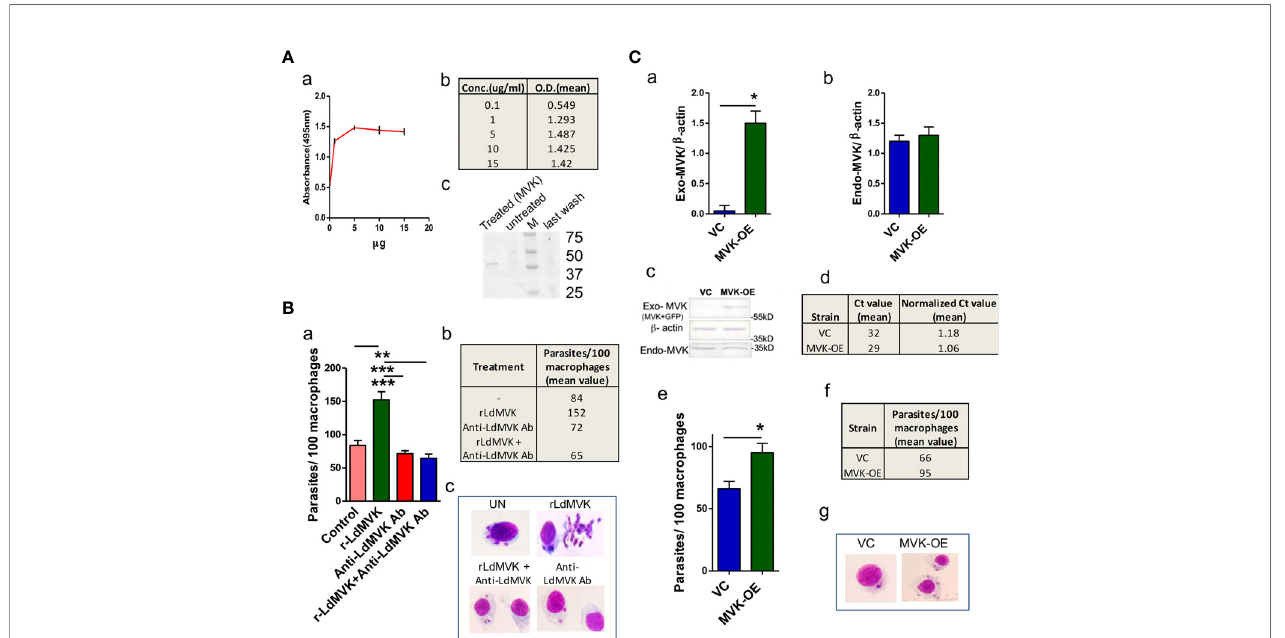
FIGURE 5 | LdMVK facilitates parasite invasion. (A) rMVK binds to the surface of macrophages. (a) Graph depicts the binding of rLdMVK on macrophages in a dose-dependent manner. Fixed macrophage cells were incubated with increasing protein concentration. The result shows mean of three independent experiments performed in triplicates. (b) Table representing the mean O.D. of experiments performed in triplicates of aforesaid described adhesion assay. (c) Blot representing binding of r-LdMVK to macrophage cell surface. PBMC-derived macrophage was incubated with r-LdMVK for 1 h, washed four times with PBS-CM, and lysed using RIPA buffer containing phosphatase inhibitors. Lysate was separated on SDS-PAGE gel and incubated in anti-MVK antibody. The image is representative of three independent experiments. Treated, macrophages incubated with r-LdMVK; untreated, macrophages without any protein incubation; M, protein marker; last wash, last wash of three washes performed post MVK incubation. (B) Infection of macrophages on rLdMVK treatment. (a) PBMC-derived macrophages were treated with Ld promastigotes, 1 µg/ml r-LdMVK+Ld promastigotes, anti-MVK antibody + Ld promastigotes and r-LdMVK + anti-MVK antibody + Ld promastigotes for 4 (h) Parasite to cell ratio was 10:1. Error bars shows SE from three independent studies. (b) Table depicting the mean value of parasites internalized per 100 macrophages on different incubations. (c) Representative image of Giemsa stained infected macrophages on various treatments. (C) Infection of macrophages by MVK-overexpressed and vector control parasites. (a) Bar graph representing normalized band intensity of exogenous MVK (exogenous-MVK/ b -actin) in VC and MVK-OE parasites. Error bars shows SE from three independent studies. (b) Bar graph representing no signi fi cant change in the level of normalized band intensity of endogenous MVK (endogenous-MVK/ b -actin) in VC and MVK-OE parasites. Error bars shows SE from three independent studies. (c) Western blot con fi rmation of generation of MVK-Overexpression strain. Whole cell lysate of MVK-Overexpression and vector control strains of Ag83 parasites were prepared, separated on SDS- PAGE gel, and probed with anti-MVK antibody. The image is representative of three independent experiments. VC, only pLGFPN transfected parasites; MVK-OE, GFP-tagged MVK-overexpressed parasites. (d) Real time PCR con fi rmation of generation of MVK-Overexpression strain. RNA from MVK-Overexpression and vector control strains of Ag83 parasites were prepared; after cDNA preparation real time PCR was carried out. Table is showing the mean normalized Ct value from these experiments. (e) Bar graph representing the number of internalized parasites per 100 macrophages. PBMC-derived macrophages were treated with mutant stains of parasites with 1:10 macrophage to parasite ratio for 4 (h) Macrophages were washed, stained, and internalized parasites were counted. The data represents the mean±SE of three experiments carried out in triplicates. (f) Table showing the mean value of internalized parasites per 100 macrophages from three experiments. (g) Representative image of Giemsa stained vector control and MVK overexpressed parasites treated macrophages. p value < 0.05 is denoted by *, p value ≤ 0.01 is denoted by ** and p value ≤ 0.001 is denoted by 1/2 was shown to be upregulated more than two times after 15 min MVK treatment ( Figures 6A, B ). On the contrary, no signi fi cant change was observed in the phosphorylation status of p38 MAP kinase ( Figures 6A, C ). Cortactin, a key actin scaffold